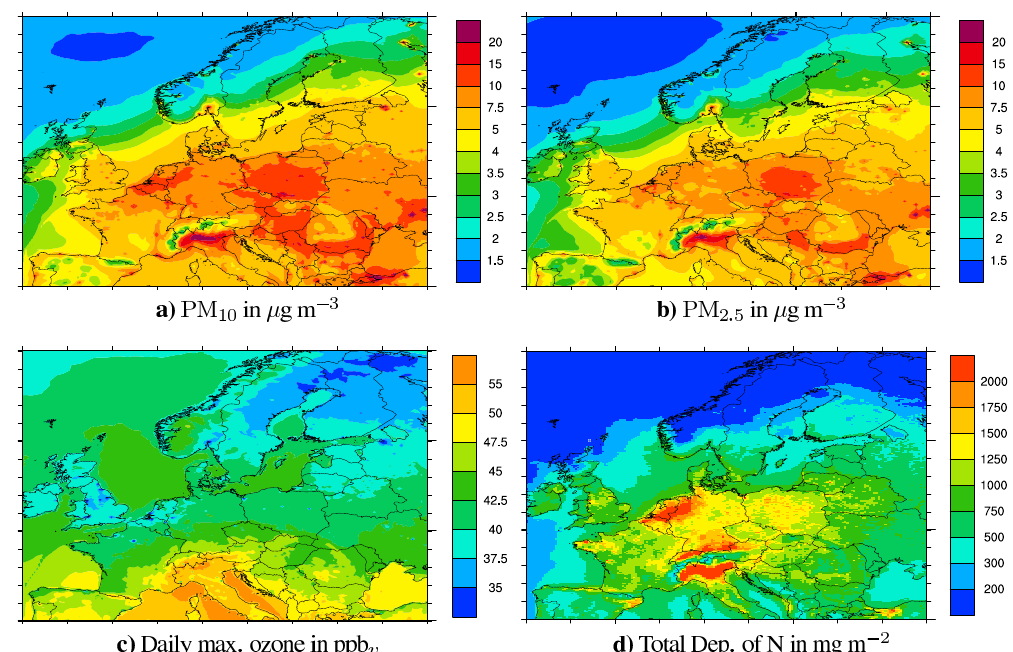
Figure 2. Modelled annual-mean concentrations of PM 10 (a) , PM 2 . 5 (b) , daily maximum ozone (c) , and the total deposition of nitrogen (d) .